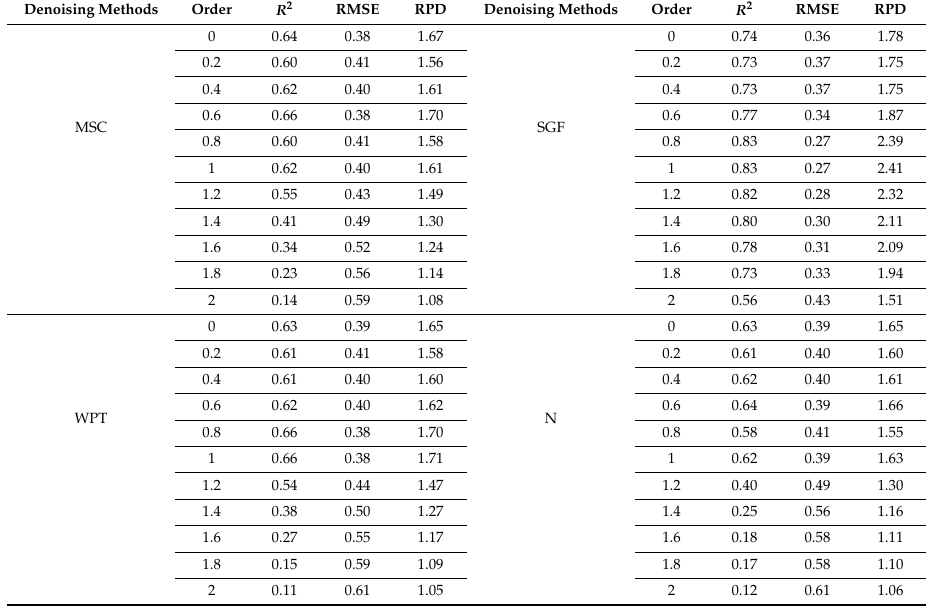
Table A3. SOM Content Estimation Model Results through LLE dimensionality reduction. DenoisingMethods Order R